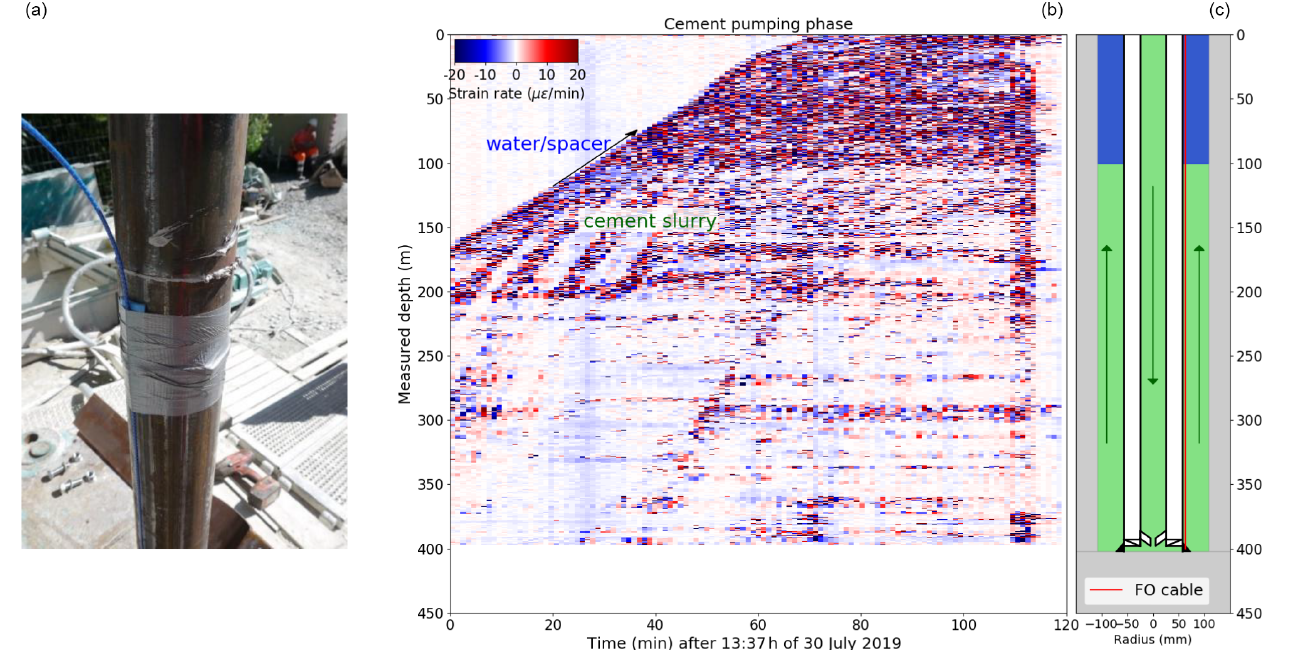
Figure 13. Panel (a) shows the fiber-optic cable (blue) fixed at the 4.5in. (115mm) borehole casing of S1. Blue separators can be seen beneath the tape to improve the cable coupling. Panel (b) presents the fiber-optic distributed strain rate measurements during cementing of the 4.5in. (115mm) casing. Panel (c) provides a sketch of cementing (flow indicated by arrows); the cement suspension (green) and spacer fluid (blue) are schematically depicted for the time of